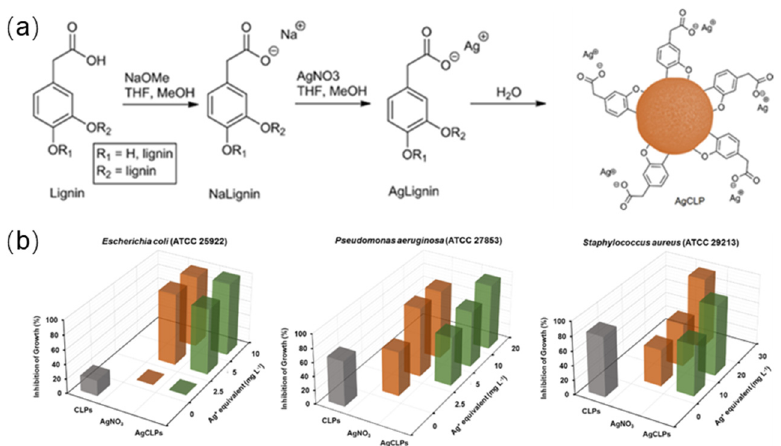
Figure 7. ( a ) Simplified Scheme of AgCLP formation; ( b ) quantification of inhibition of growth as a function of Ag + equivalent of AgCLPs and control samples on CLPs and AgNO 3 after 24 h exposure. Reprinted with permission from Ref. [48]. Copyright 2019 American Chemical Society.